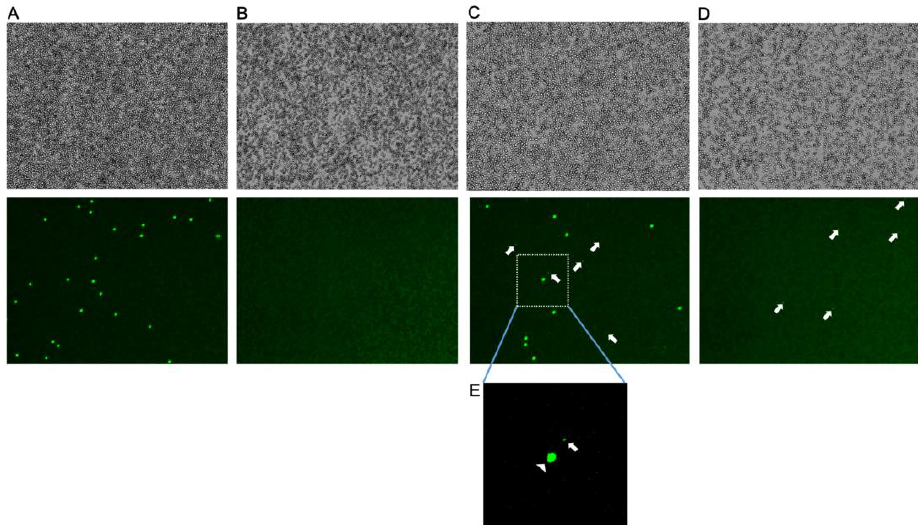
Figure 4. Bright-field and fluorescent images captured using LUNA-FL. Whole blood ( A ), whole blood after filtration ( B ), whole blood spiked with parasite-infected erythrocytes ( C ), or whole blood spiked with parasite-infected erythrocytes after filtration ( D ) were analysed using LUNA-FL. Each sample was stained with AO. Typical bright-field images (upper panels) and the fluorescent images (lower panels) are shown. The signals corresponding to the parasites are indicated by arrows. ( E ) An enlarged image of (C) is shown. A leucocyte is indicated by an arrowhead, and a parasite is indicated by an arrow.